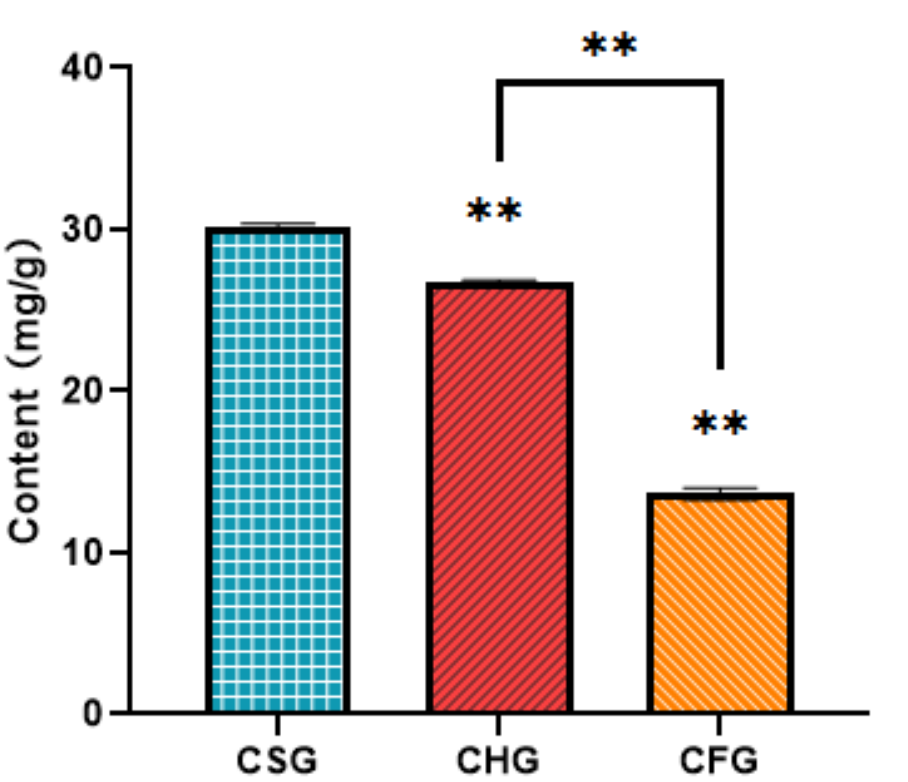
Figure 1. Content analysis of total flavonoids in T. chinensis from different hosts (CSG, CHG, and CFG). ** above the histogram indicates statistical significance ( p < 0.01).